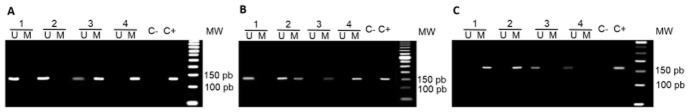
Methylation analysis of the kinases promoters showing methylated and unmethylated bands.A) SRC promoter methylation analysis, in which samples 1 and 2 presented hypomethylated promoter, sample 3 presented partial methylation and sample 4 presented hypermethylated promoter; B) LYN promoter methylation analysis, in which samples 1 presented hypomethylated promoter, sample 2 presented partial methylation and samples 3 and 4 presented hypermethylated promoter; C) CKB promoter methylation analysis, in which samples 1 and 2 presented hypermethylated promoter, and samples 3 and 4 presented hypomethylated promoter. C–: blank; C+: positive control, gDNA sample completely methylated; U: PCR with unmethylated primer set; M: PCR with methylated primer set; MW: molecular weight marker; bp: base pairs.